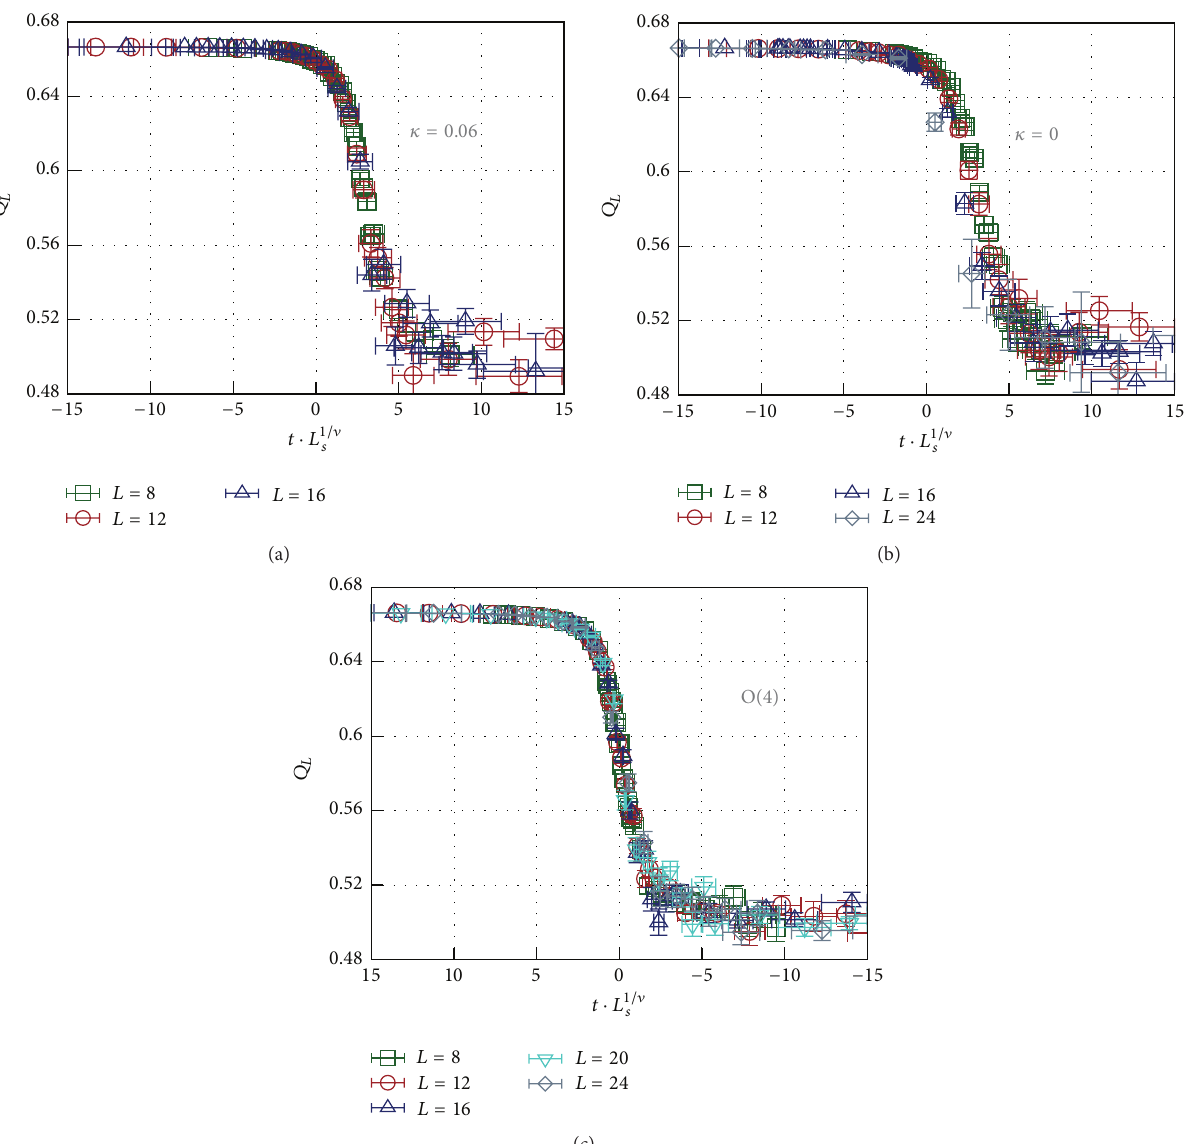
Figure 11: Scaling behaviour of Binder’s cumulant at 𝜅 = 0.06 (a), 𝜅 = 0.00 (b), and the O(4) model (c) for various volumes using the parameters listed in Table